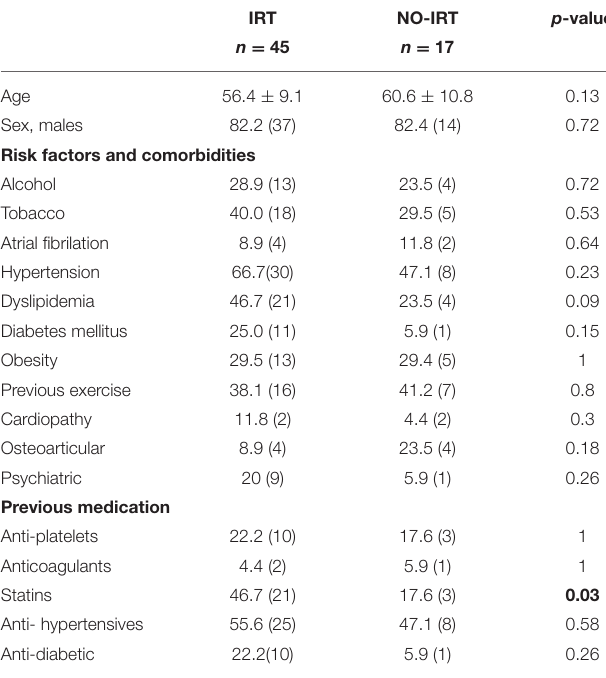
TABLE 1 | Baseline characteristics of the control and stroke cohorts. TABLE 2 | Baseline characteristics of the IRT vs. NO-IRT cohorts.